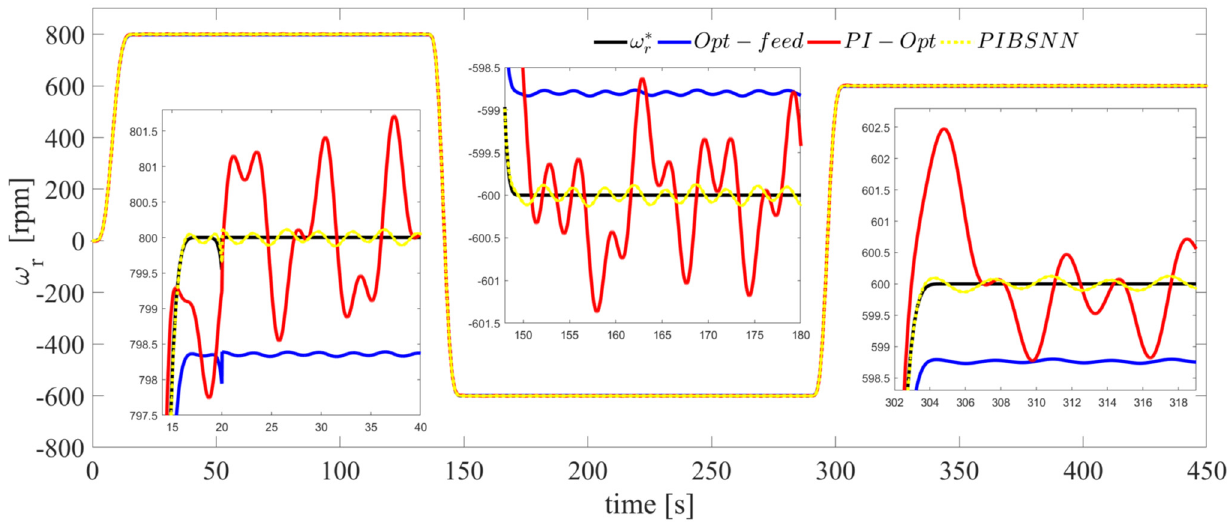
Figure 11. Tracking performance of PMSM drive with presence of fissure in the rotor shaft, abrupt changes of load torque disturbance, and unknown frictions. Table 4. Speed error performance indices for case 2.